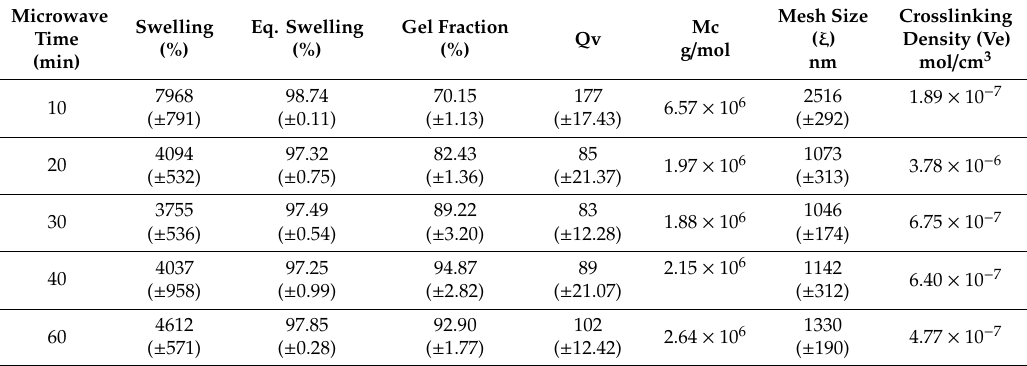
Table 5. Swelling, mesh size, and cross-linking behaviour of HA5-PT15 hydrogels crosslinked by the microwave